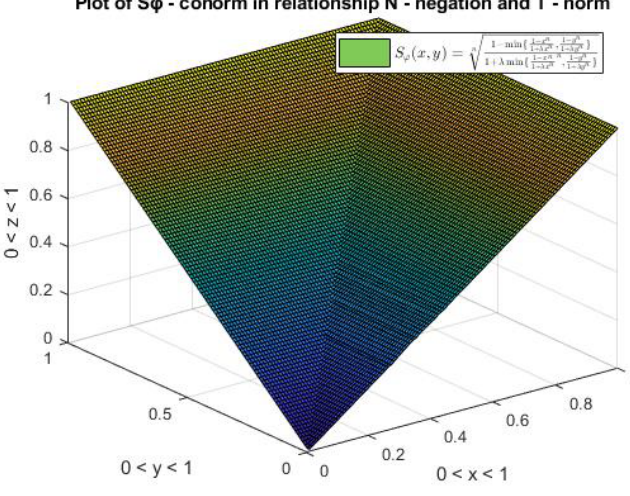
Figure 6. S-conorm generated from S ( x , y ) = N ( T ( N ( x ) , N ( y ))) using an automorphism function. (vi). The function I ϕ satisfies the properties of the family of fuzzy implications. The Figure 7 is shown below.